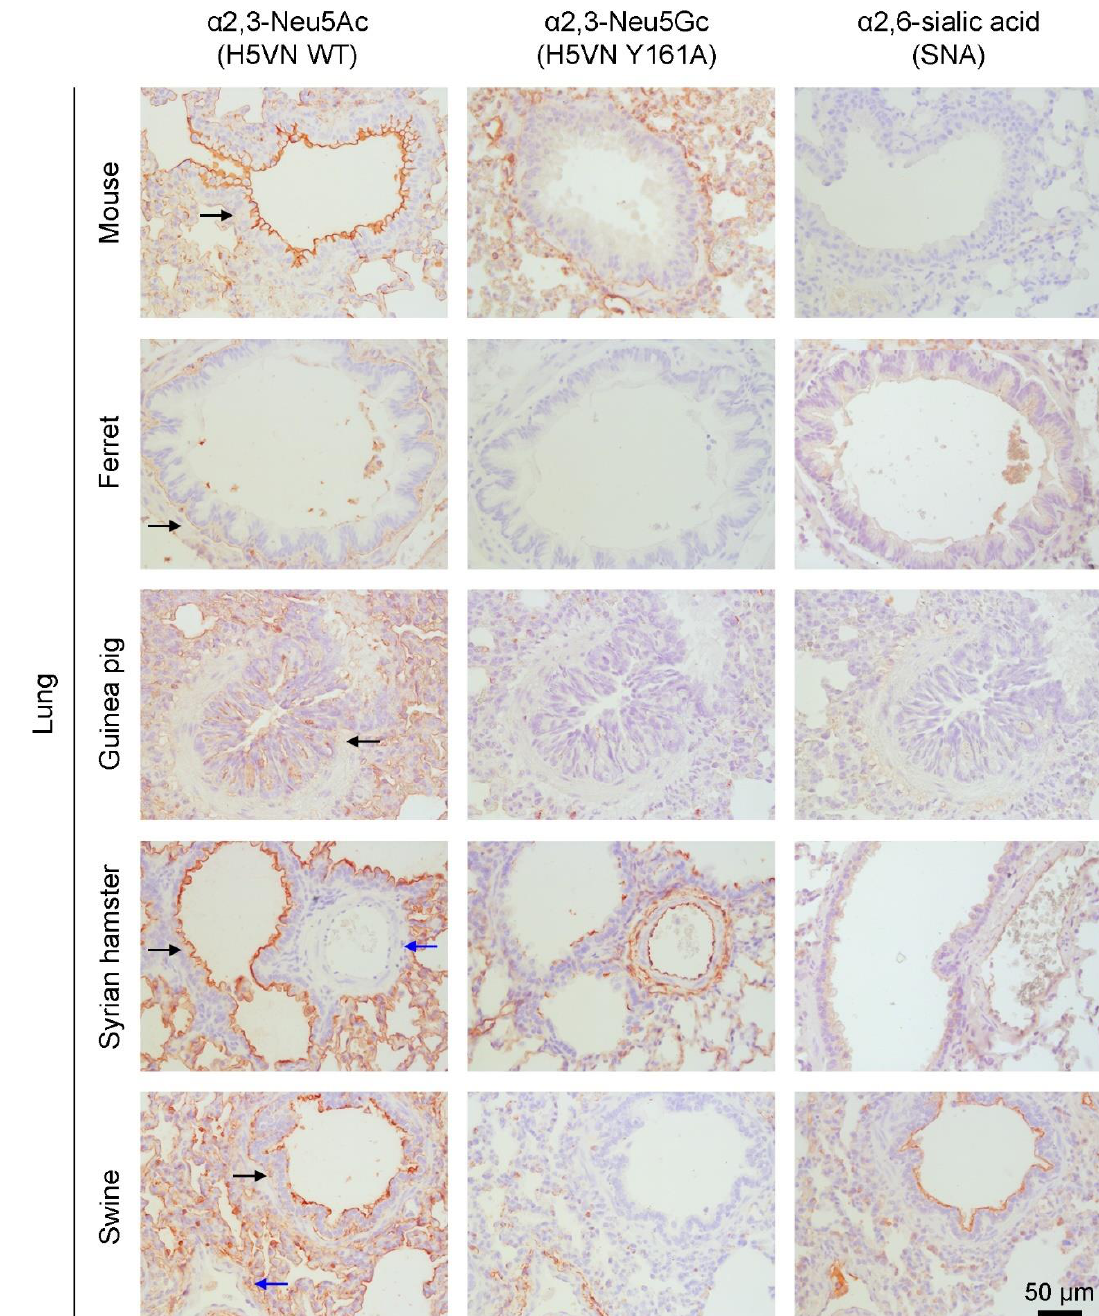
Figure 2. Visualization of the presence of α2,3 linked Neu5Ac (WT HA of A/Vietnam/1203/2004 (H5N1)), α2,3 linked Neu5Gc (Y161A mutant HA of A/Vietnam/1203/2004 (H5N1)), and α 2,6 linked sialic acids (SNA) using AEC staining on lung tissue of mouse (C57BL/6), ferret, guinea pig, Syrian hamster, and domestic swine. Brown staining indicates binding of the HAs to the tissue and blue indicates the cells. Selected bronchioles (black arrows) and blood vessels (blue arrows) are indicated. Images are representative of two independent experiments.